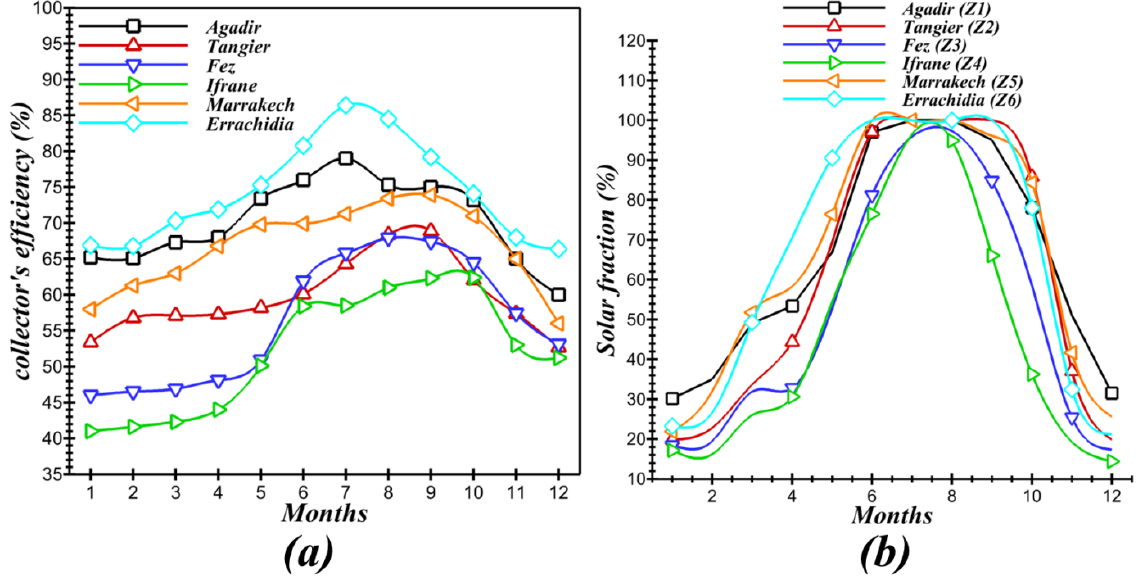
Figure 13. ( a ) Solar fraction. ( b ) Collector’s efficiency. Tangier (Zone 2) and Marrakech (Zone 5) exhibit approximately the same solar fraction variation, but (Zone 5) has a higher annual average value of 66% versus 61% in (Zone